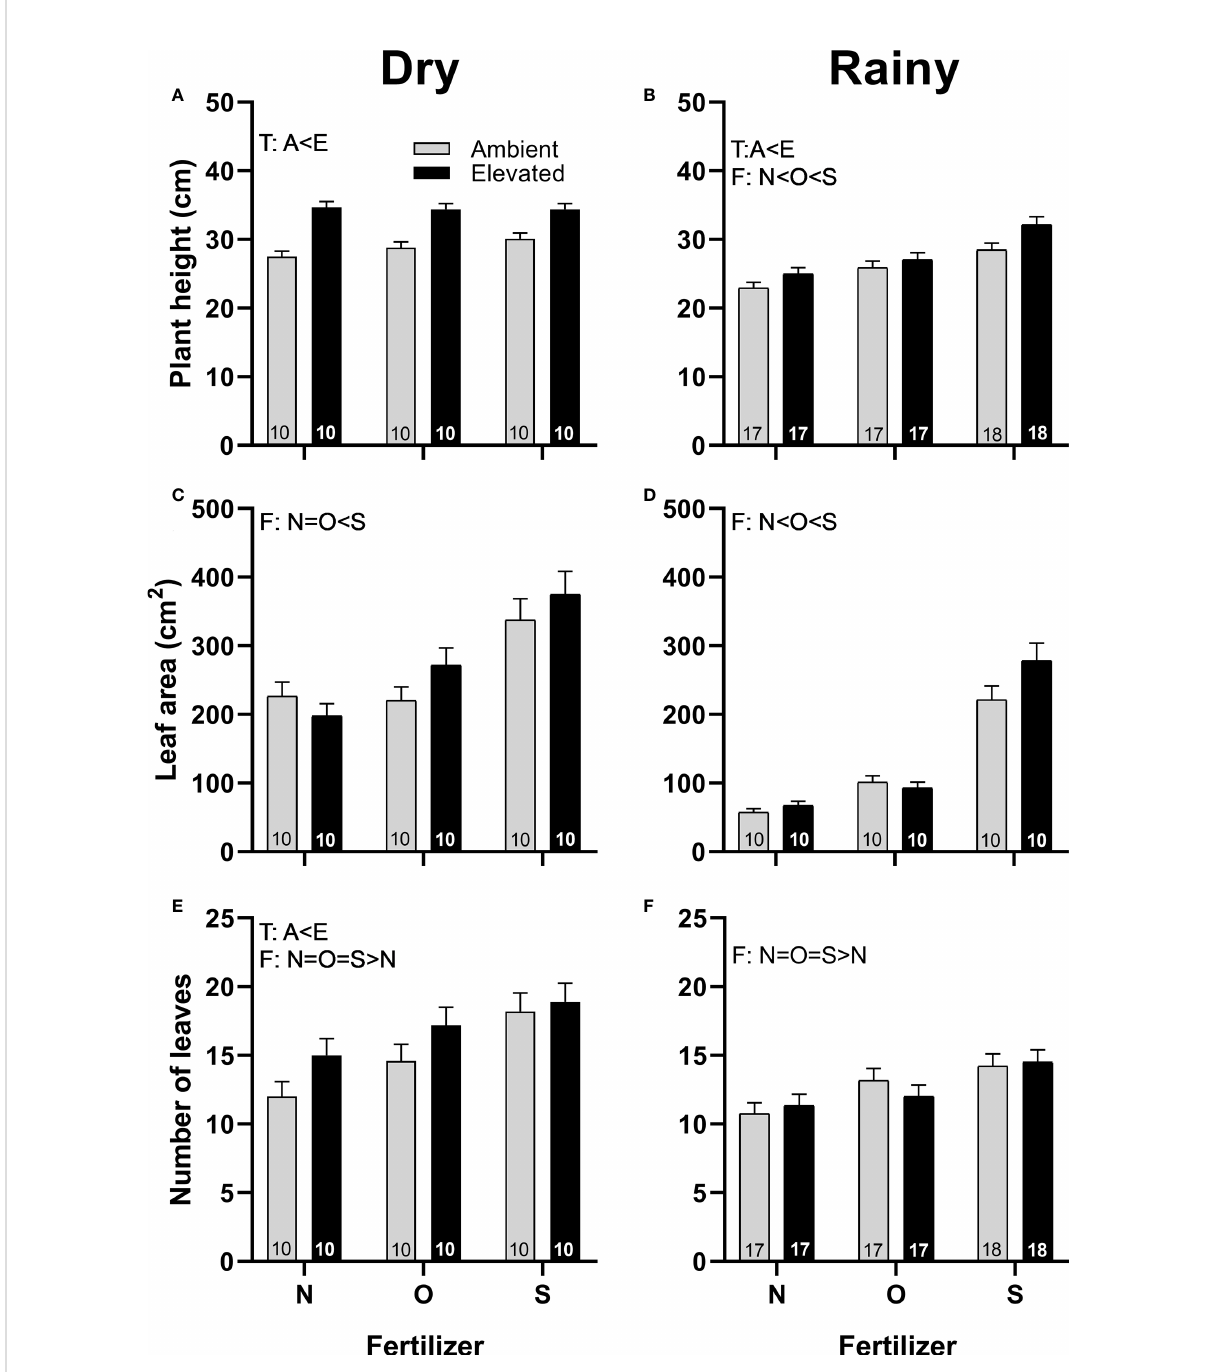
FIGURE 2 Effects of the increase in temperature (T) and addition of fertilizer (F) on plant height (A, B) , leaf area (C, D) , and the number of leaves produced per plant (E, F) of C. pepo during the dry (left) and the rainy (right) season (mean ± SE; n: number inside bar). Signi fi cant differences in the main factors (T or F) are represented with capital letters (A, ambient temperature; E, elevated temperature; N, no supplementary fertilizer; O, organic fertilizer; S, synthetic fertilizer). Mean and standard deviation values are in Supplementary Tables 1, 2 and the results of the statistical tests are summarized in Supplementary Table